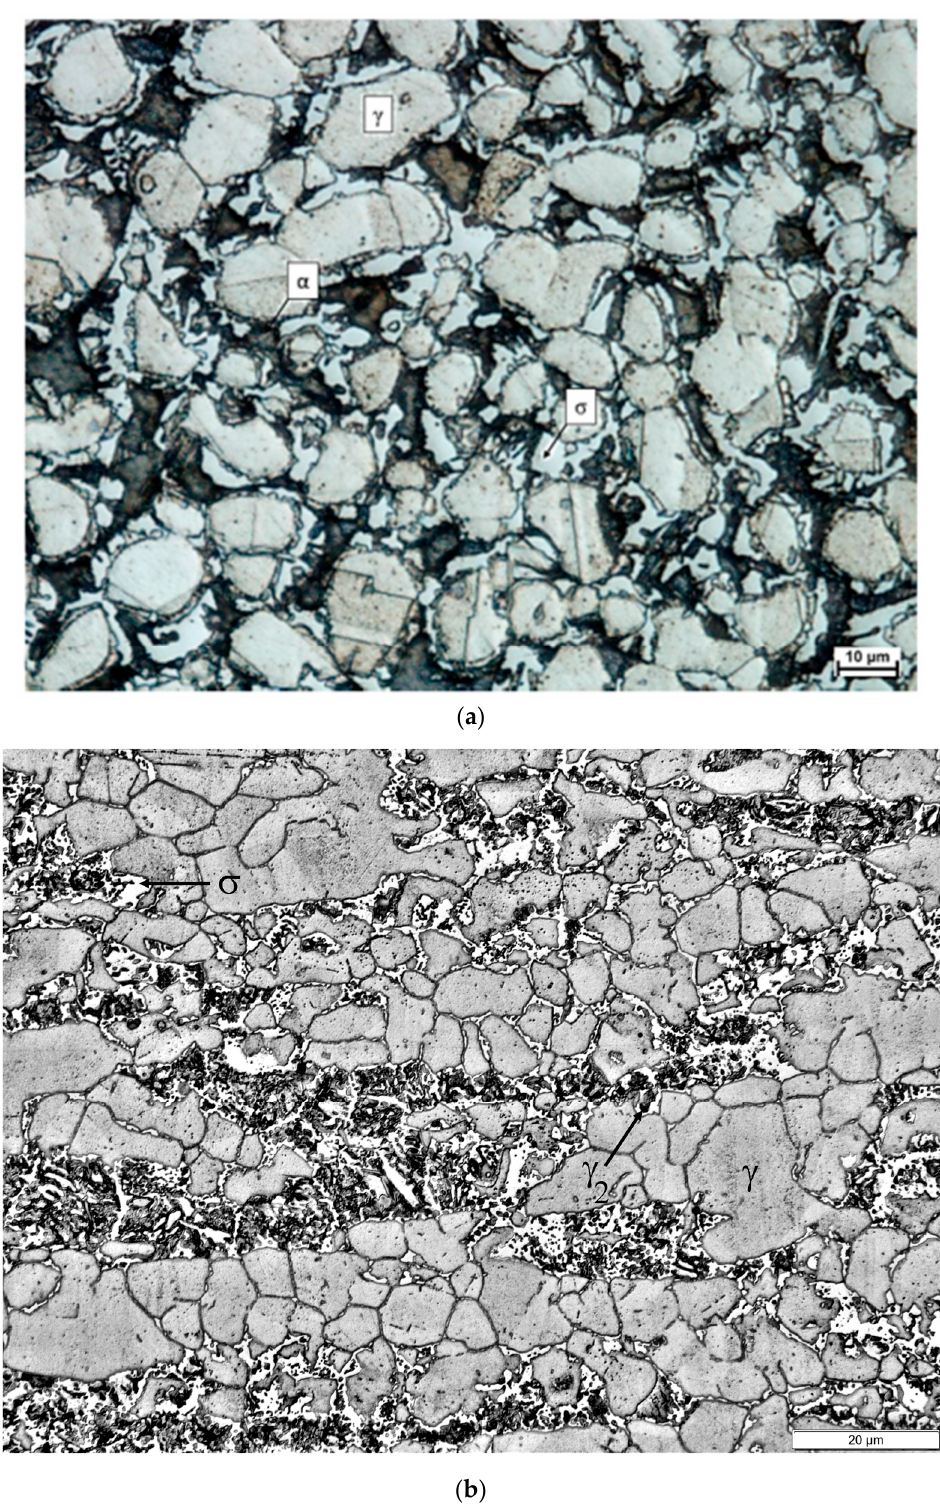
Figure 2. ( a ) Micrograph of DSS aged 79,200 s (22 h) at 800 °C. One can see grains of austenite ( γ ), depleted ferrite ( α ; black), and sigma phase ( σ ; white). ( b ) Micrograph SDSS aged 180,000 s (50 h) at 750 °C. One can see austenite ( γ ), secondary austenite ( γ 2 ; black), and sigma phase ( σ ; white). The volume fraction of ferrite and austenite for the treated samples, shown in Figure 2a, are 0.10 ± 0.01 of ferrite and 0.45 ± 0.01 of austenite in DSS. The sigma phase presented a continuous morphology. The volume fraction of sigma phase was about 0.45. Thus, ferrite decomposition is given by 𝛼 → 𝛼 ∗ + 𝜎 , where α * is depleted ferrite. The literature of superferritic steels [7] also contains